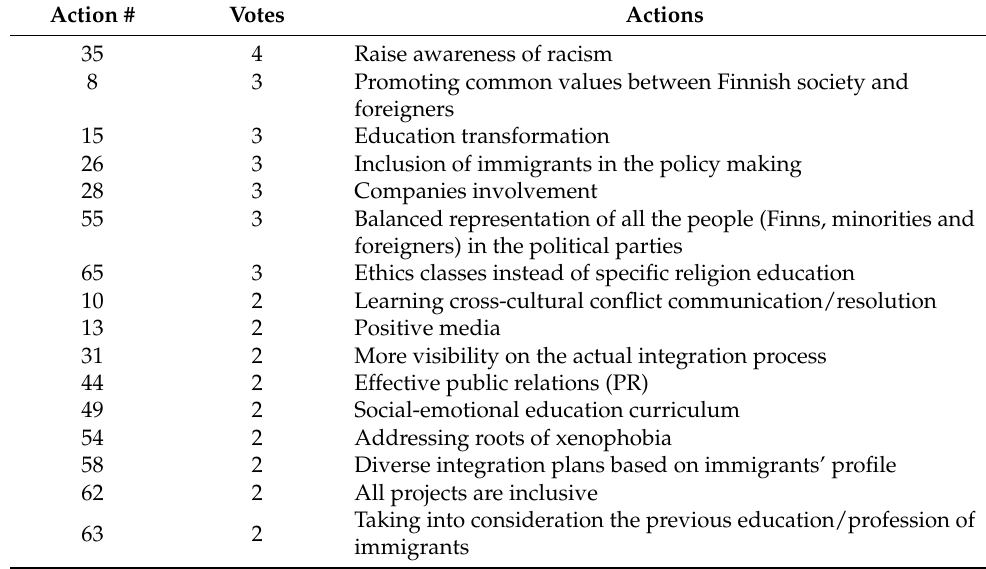
Figure 4. Clusters 7–8 of the proposed actions. Table 1. The number of votes for actions.